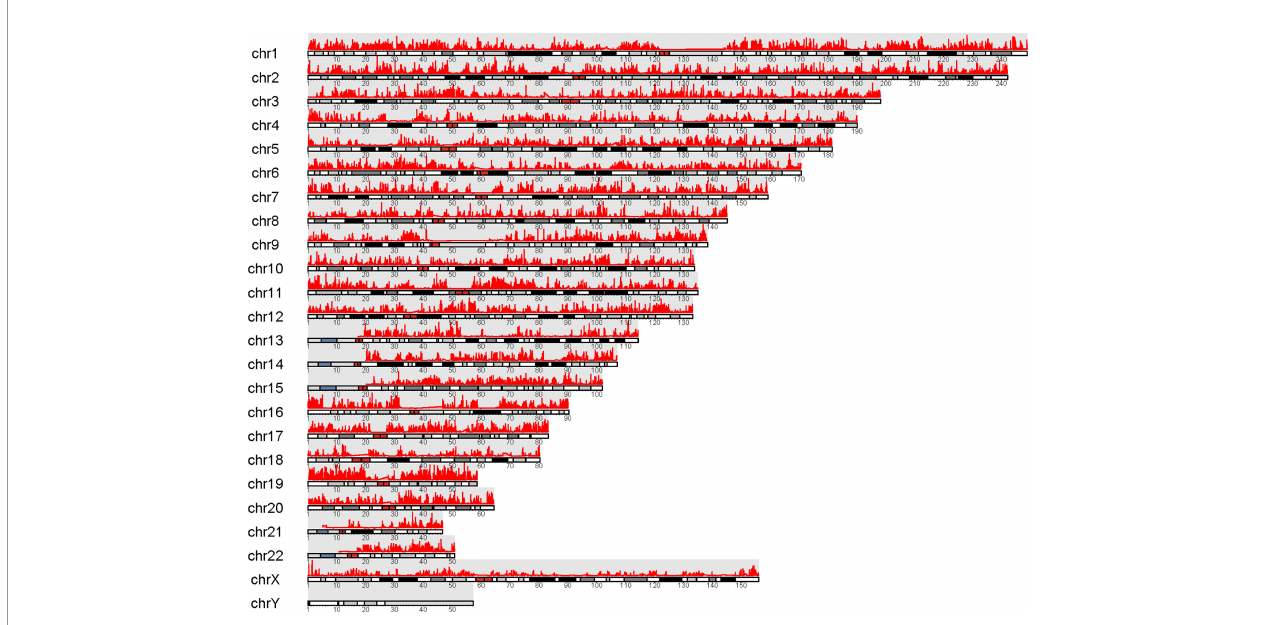
FIGURE 5 | Visualization of peaks (marked in red) over chromosomes. Chromatin accessibilities were widely present over the whole